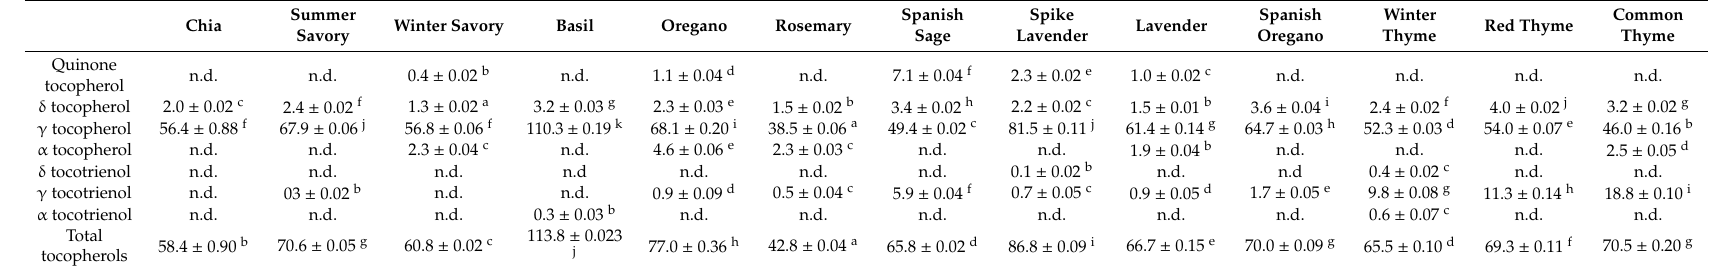
Table 2. Tocopherol content in the Lamiaceae seed oils (mg / 100 g of